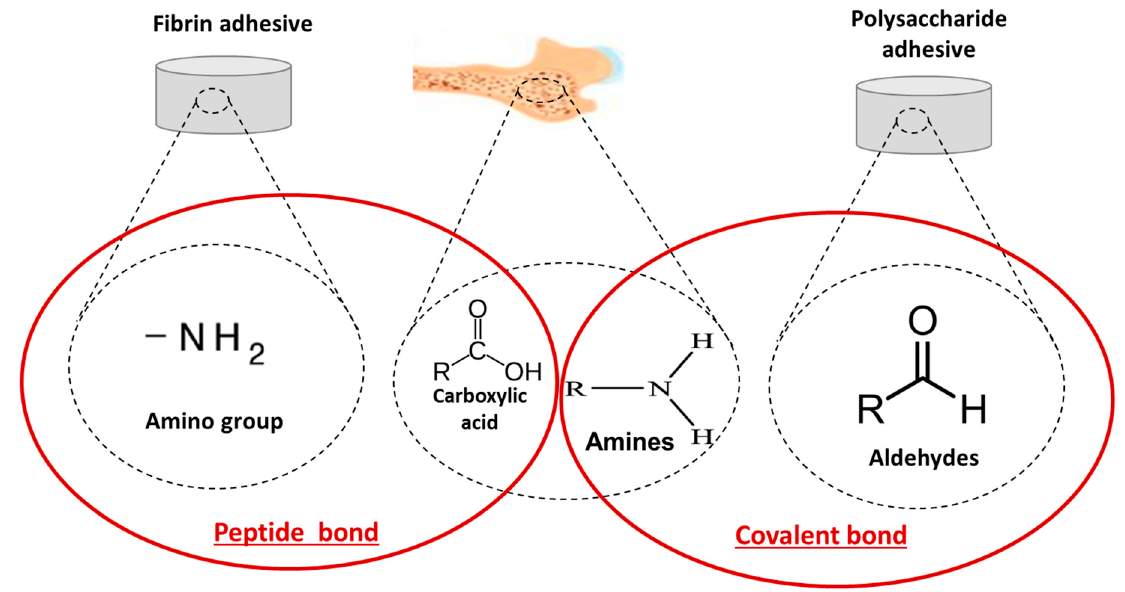
Figure 9. Covalent bond between amino groups of fibrin/fibronectin and/or aldehydes of polysaccharide-based adhesive system, with carboxylic acid groups and amines present in bone collagen